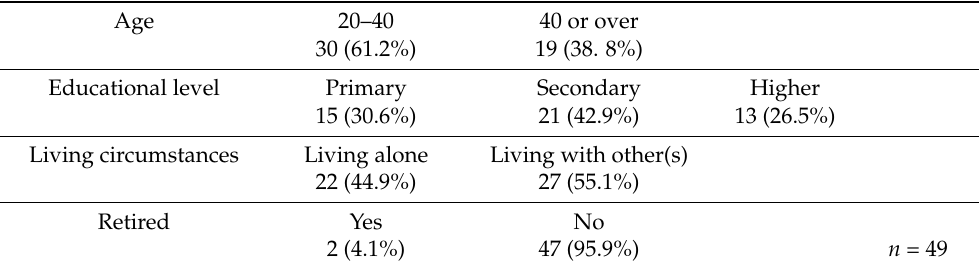
Table 1. Sociodemographic data for patients with RRMS.